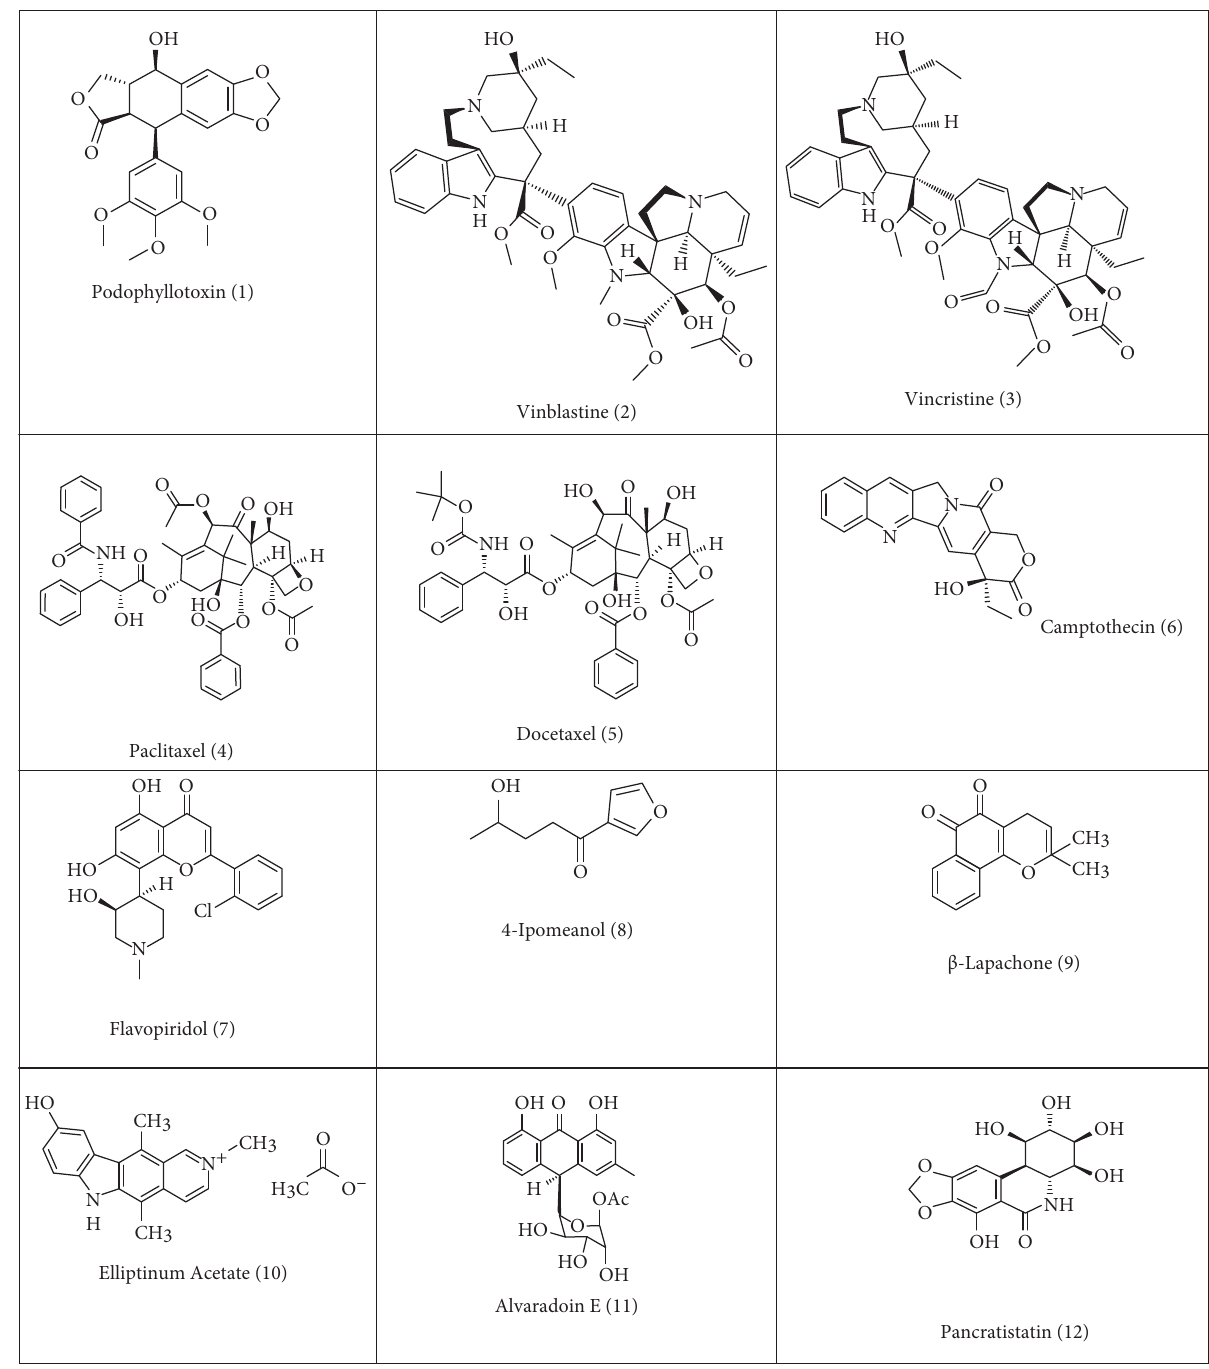
Figure 1: Chemotherapeutic agents obtained from plant